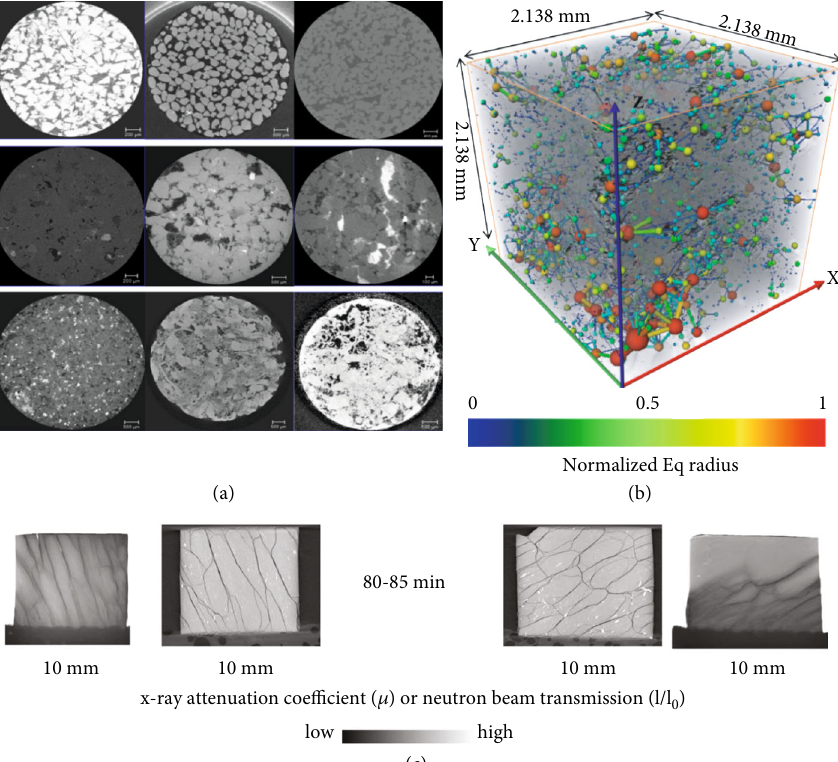
Figure 2: (a) Cross-section of original CT (computed tomography) image [41]. (b) Extracted pore network model from shale rock sample S9 [41]. (c) X-ray and neutron tomography images of imbibition process over 80-85 mins [31]; P or T: parallel or transverse to the bedding plane.